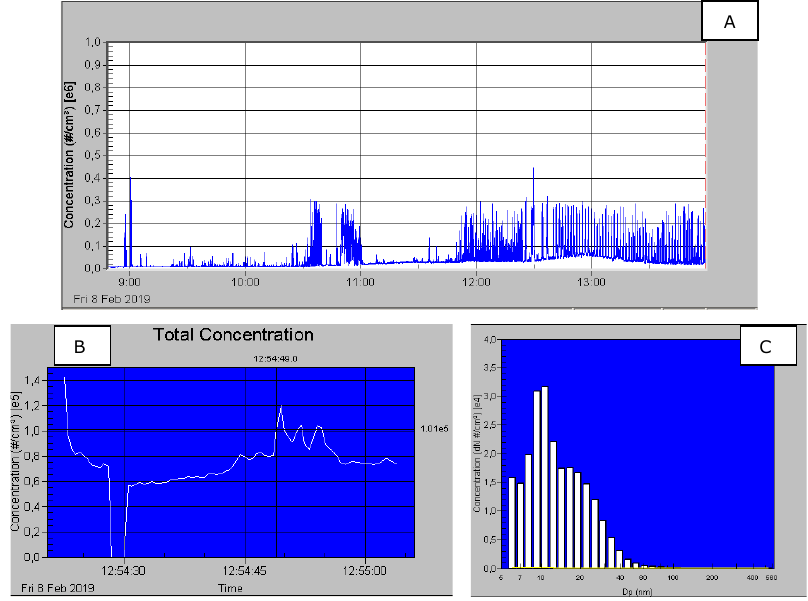
Figure 5 . Nanoparticles during ABS printing. A (CPC concentration), B (EEPS concentration), C (EEPS size distribution) On the 11 th of February, when printing PLA filament, the concentration fell from 20,000 to 3,400 particles/cm 3 (Figure 6), indicating that the extruder had been contaminated with ABS filament from previous printing.